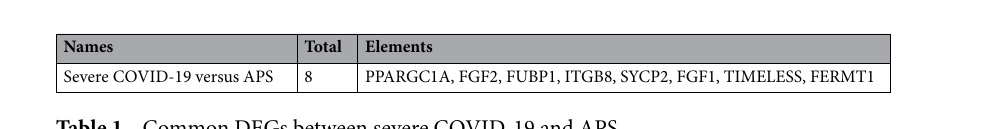
Table 1. Common DEGs between severe COVID-19 and